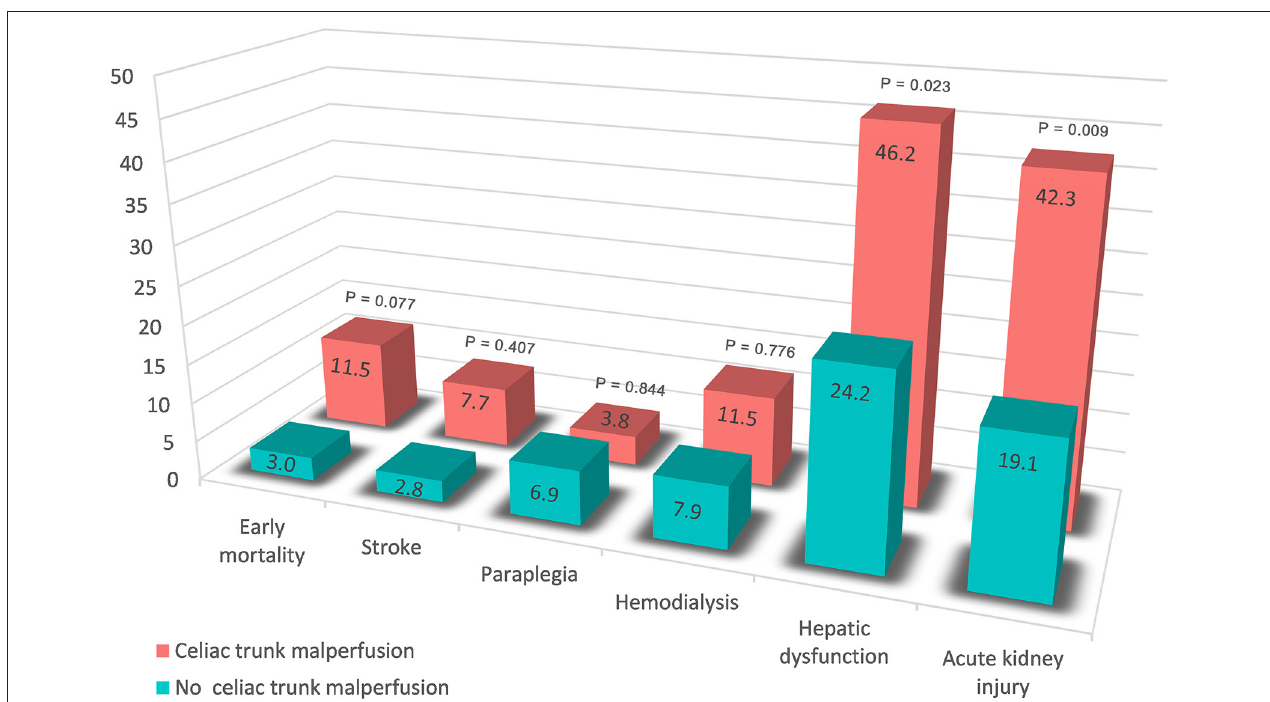
FIGURE 3 | Early outcomes in the patients with and without preoperative celiac trunk